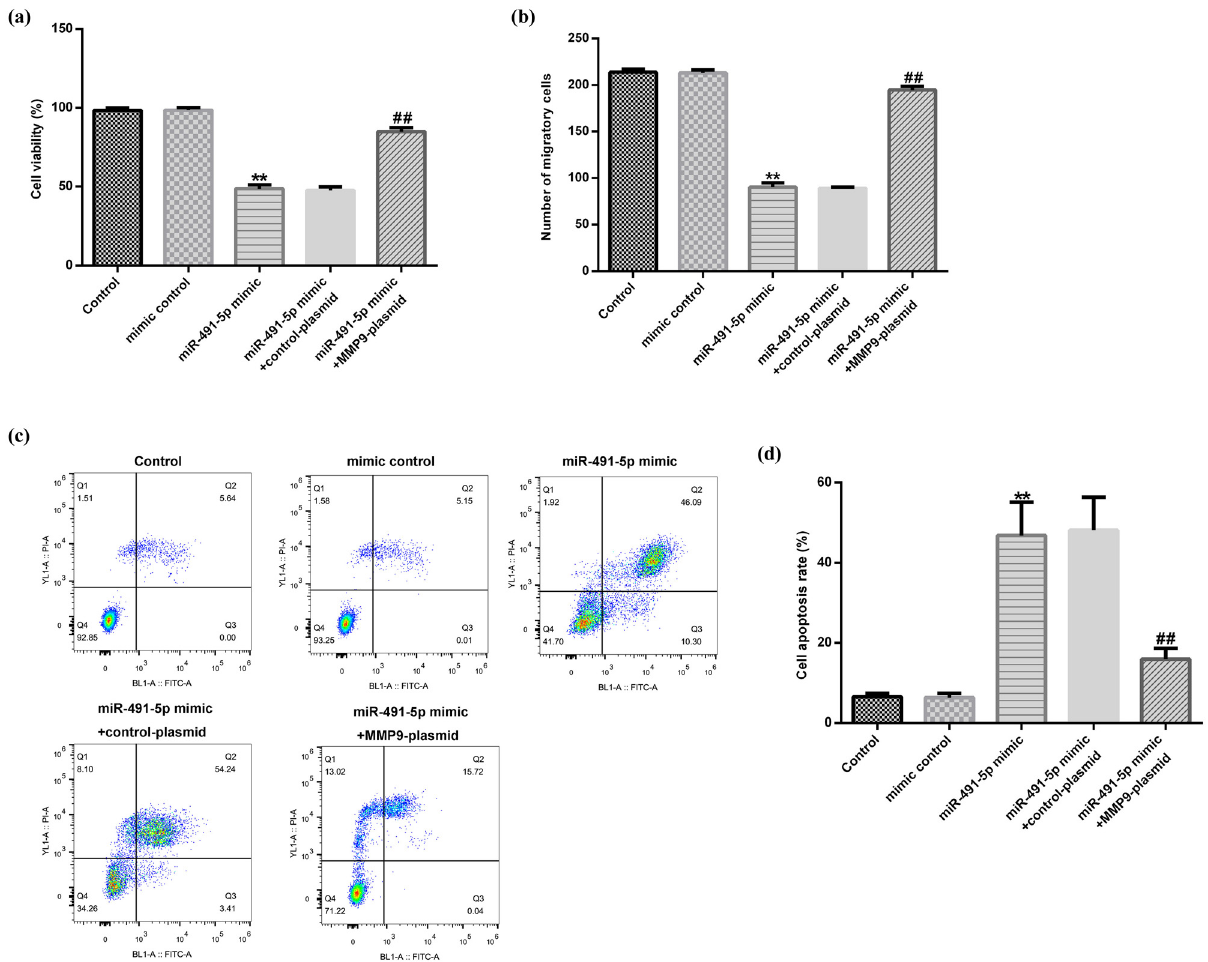
Figure 5: Overexpression of MMP - 9 abrogated the e ff ects of miR - 491 - 5p on hVSMC proliferation, migration, and apoptosis. The hVSMCs were transfected with mimic control and miR - 491 - 5p mimic alone or accompanied with control plasmid or MMP - 9 plasmid for 48 h. ( a ) The e ff ect of miR - 491 - 5p mimic on hVSMC viability was monitored by the MTT assay. ( b ) The e ff ect of miR - 491 - 5p mimic on hVSMC migration was determined by the transwell assay. ( c and d ) The e ff ect of miR - 491 - 5p mimic on hVSMC apoptosis was evaluated by the fl ow cytometric analysis. All the e ff ects were reversed by MMP - 9 plasmid. The results are shown as mean ± SD. ** p < 0.01 vs. control; ## p < 0.01 vs. miR - 491 - 5p